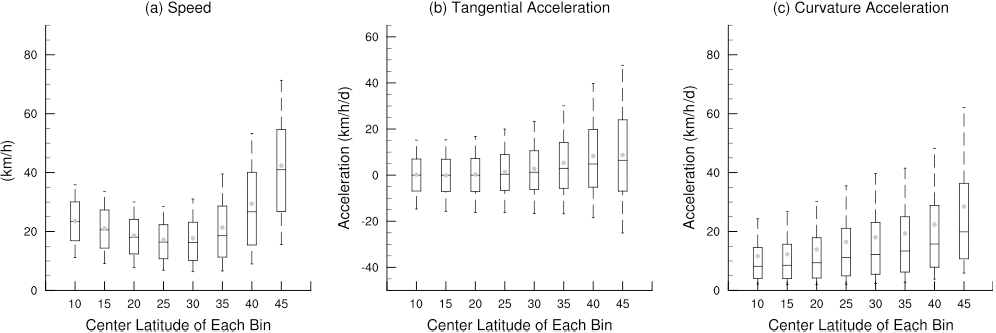
Figure 2. Distribution of (a) speed (kmh − 1 ), (b) tangential acceleration (kmh − 1 d − 1 ), and (c) curvature acceleration (kmh − 1 d − 1 ) of Atlantic TCs as a function of latitude. Storm instances classified as ET or NR were excluded. Data from 1966–2019 were binned within 10 ◦ wide overlapping latitude bins. Statistics shown are median (horizontal line within the box), mean (dot), and 10th, 25th, 75th, and 90th